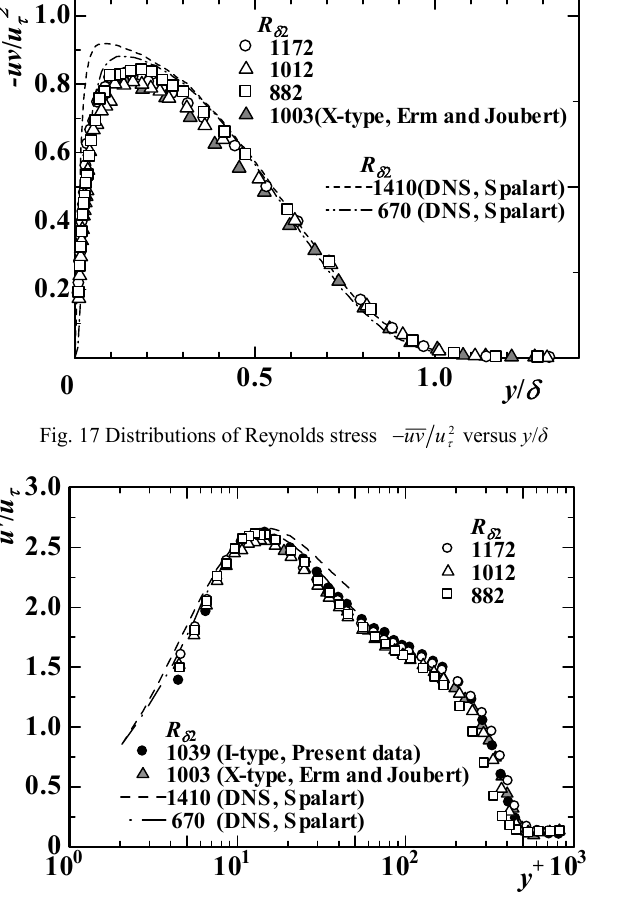
Fig. 18 Distributions of fluctuating velocity u ΄ / u τ versus y